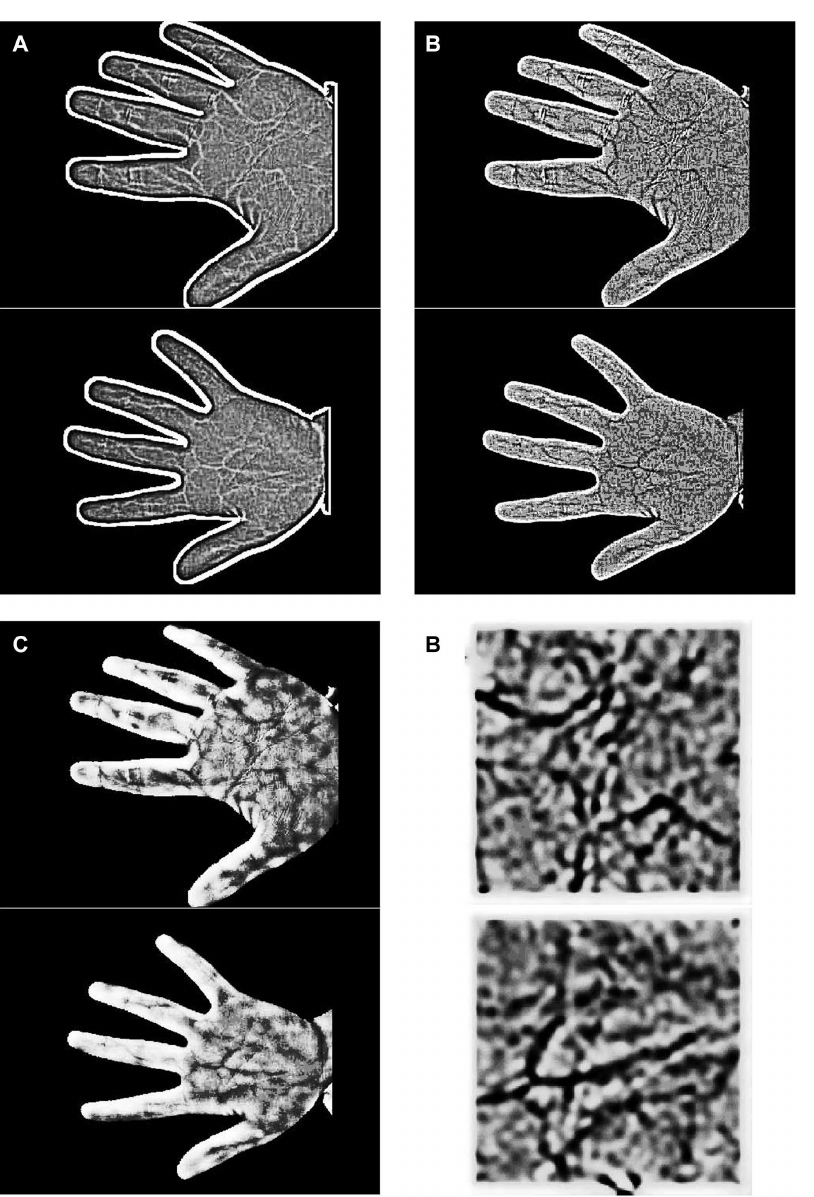
Figure 3. Image preprocessing. (a) Original images; (b) Cropping the palm region near the wrist; (c) DoG filtering; (d) Histogram equalization.